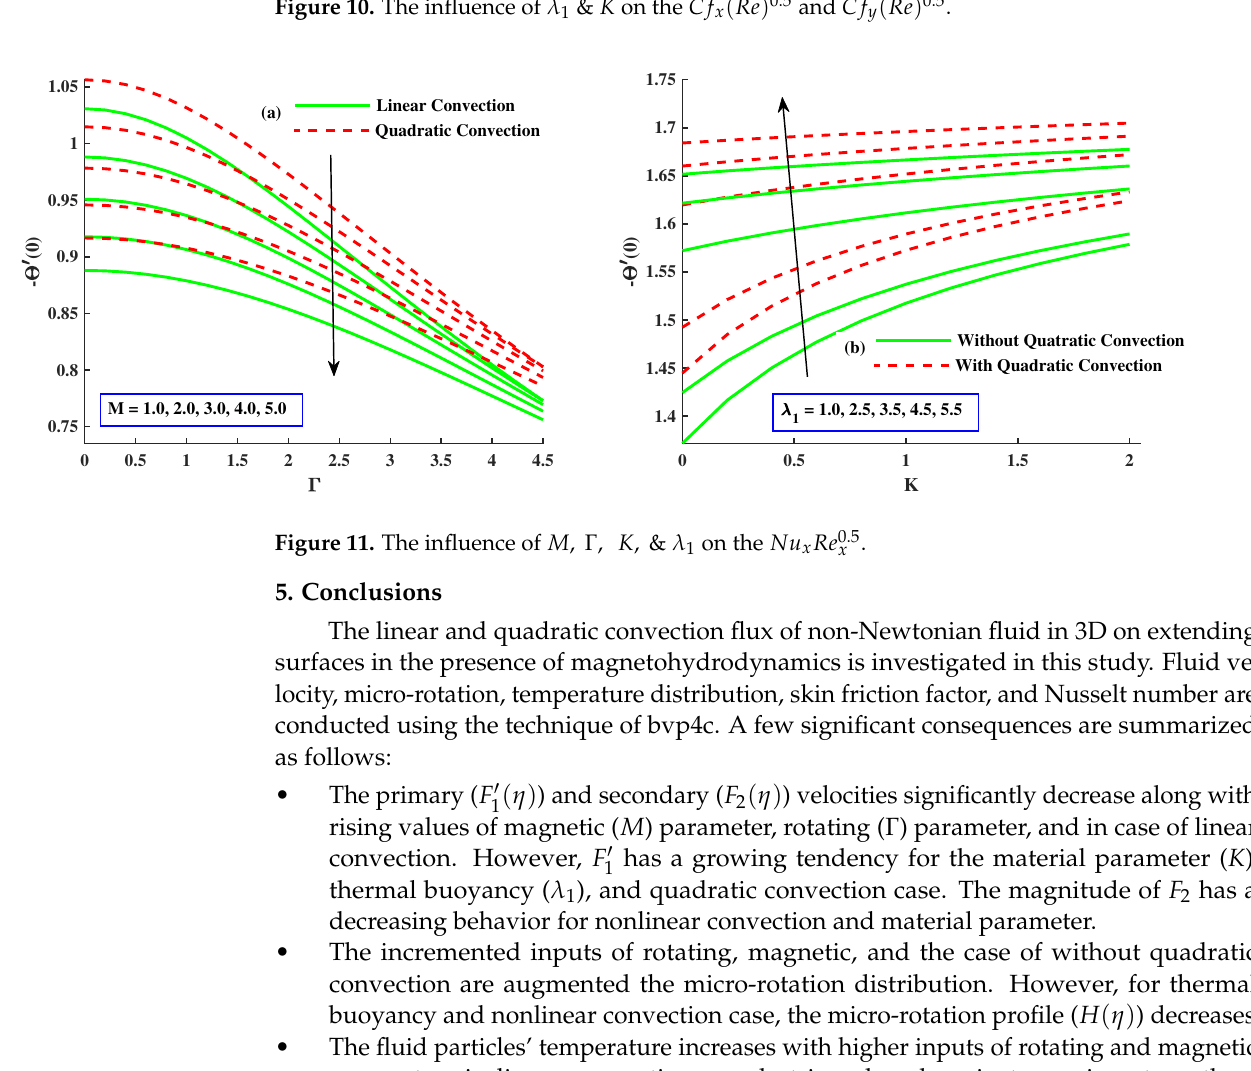
Figure 10. The influence of λ 1 & K on the Cf x ( Re ) 0.5 and Cf y ( Re ) 0.5 .